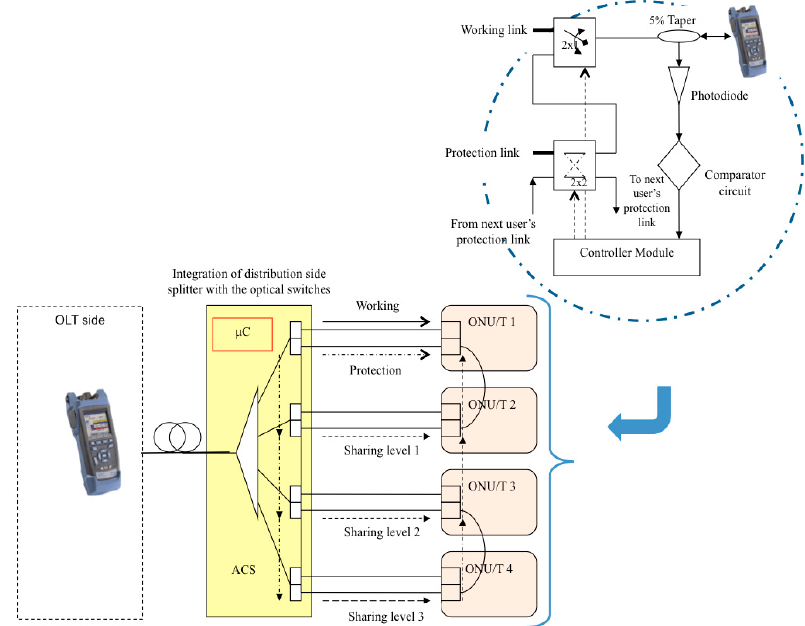
Figure 16. Experimental setup for ‘zig-zag’ scheme.